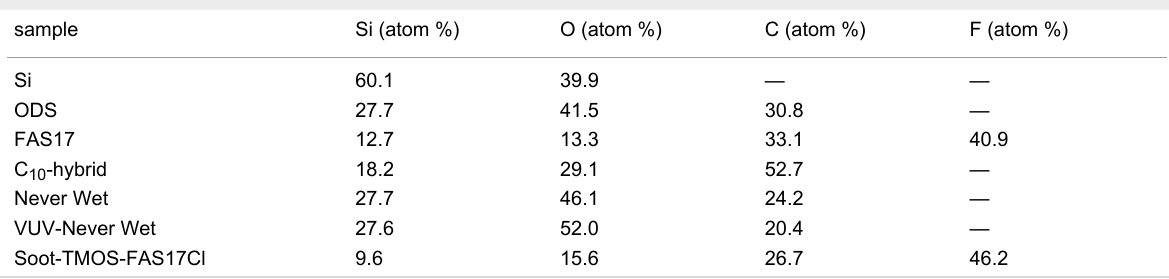
Table 2: Sample surface compositions as estimated by